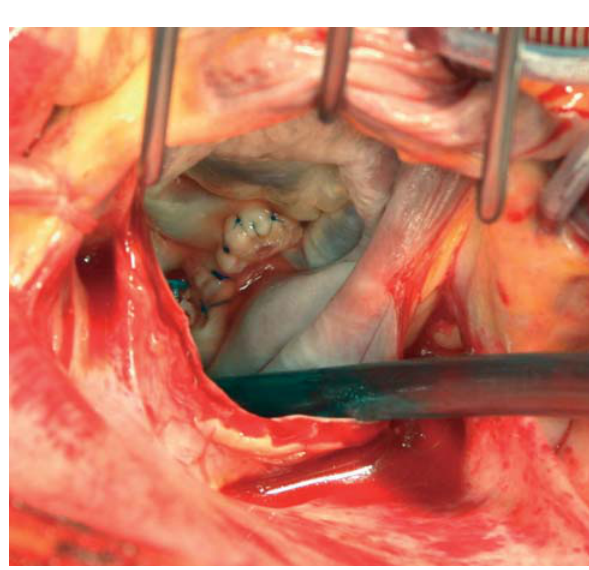
Fig. 1. Aspecto intra-operatório da valva mitral após a realização da plastia mitral pela técnica do Duplo Teflon. Podemos observar os “pledgets” ancorados nas tiras de teflon e a sutura borda a borda das